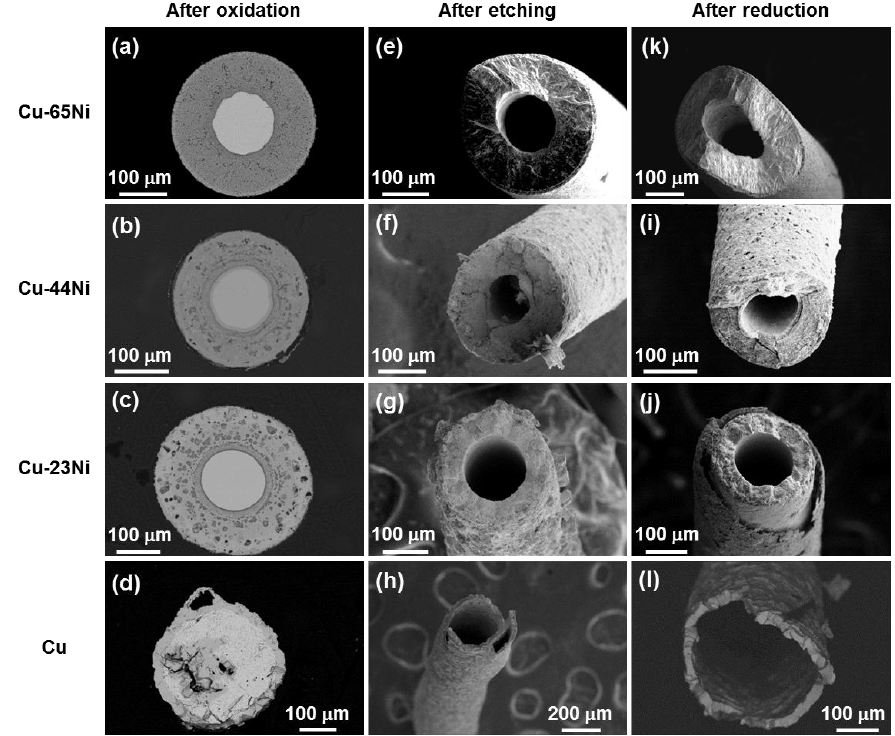
Figure 3. Backscattered electrons images of the cross section of the oxidized wires: ( a ) Cu-65Ni; ( b ) Cu-44Ni; ( c ) Cu-23Ni; ( d ) Cu. Secondary electron SEM images of the oxide microtubes obtained after chemical etching of the oxidized wires: ( e ) Cu-65Ni; ( f ) Cu-44Ni; ( g ) Cu-23Ni; and ( h ) Cu. Secondary electron SEM images of the metallic microtubes obtained after reduction of the oxide microtubes: ( k ) Cu-65Ni; ( i ) Cu-44Ni; ( j ) Cu-23Ni; and ( l ) Cu.